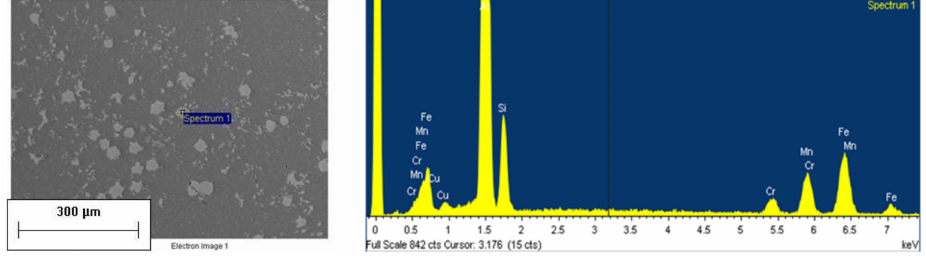
Figure 4. EDS spectrum of a sludge particle observed in C-T6 alloy [25].